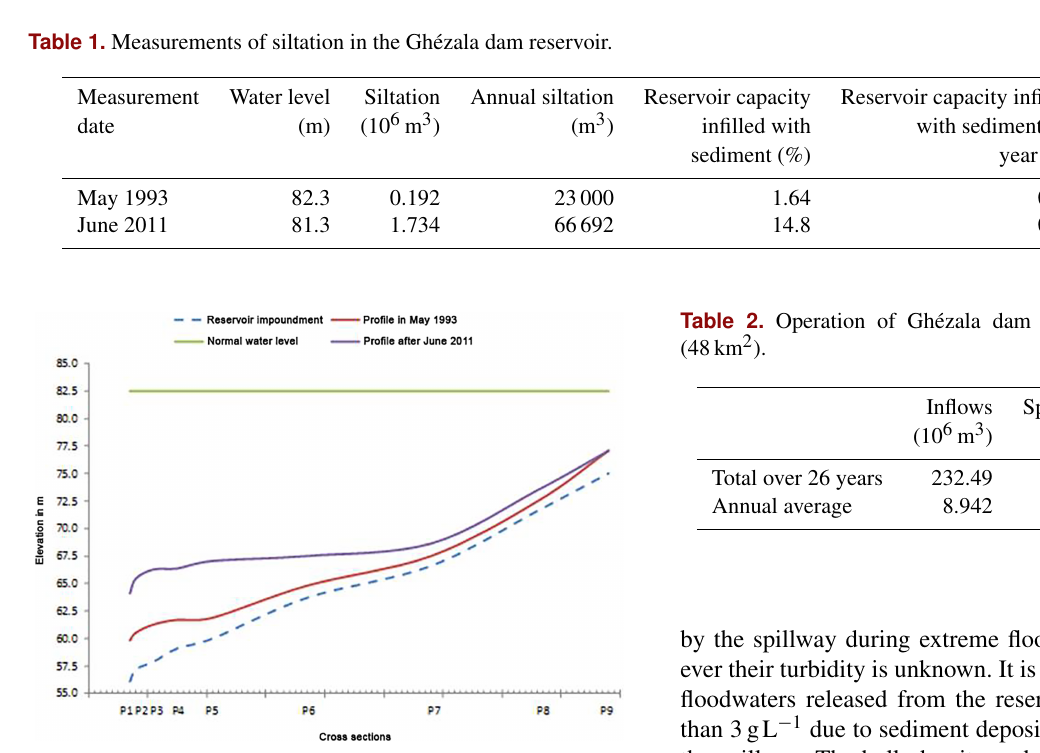
Figure 4. Profiles along Ghézala wadi before impoundment and after measurements.